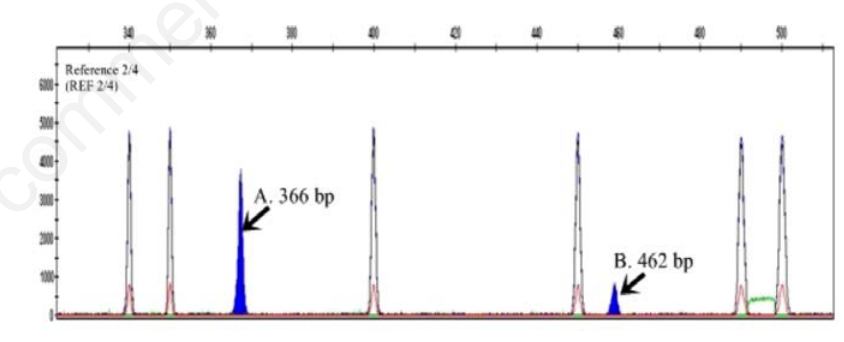
Figure 3. Electrophoregram of the Genescan Analysis of the DRD4 repeat polymorphism. The gene scan analysis of the band contain: a) 2-repeat (366 bp), b) 4-repeat (462 bp) (black arrow).